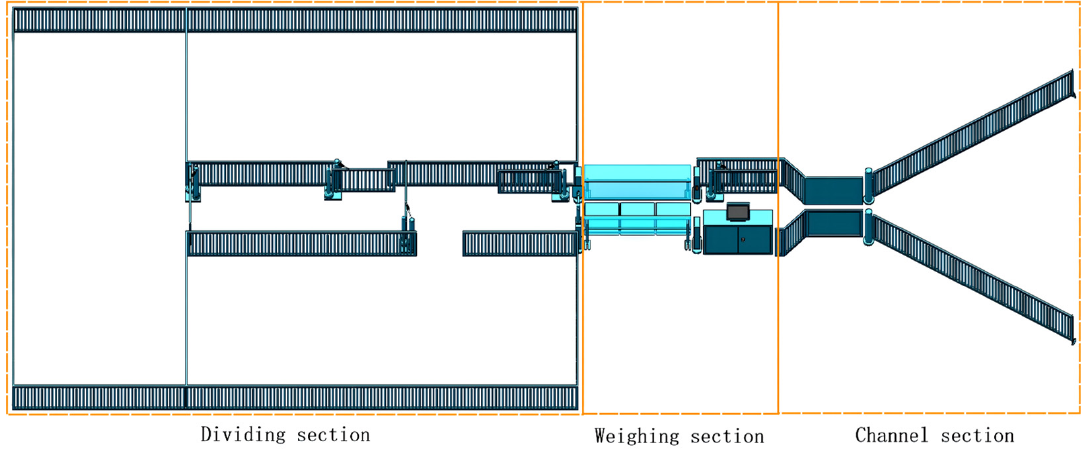
Figure 2. Overall system structure drawing.